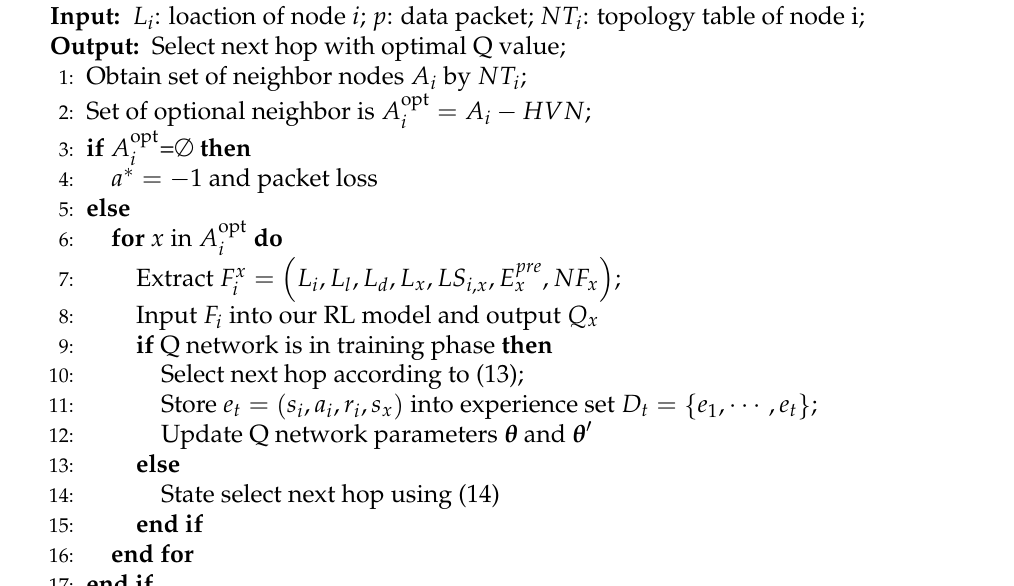
Algorithm 1 DSEGR routing